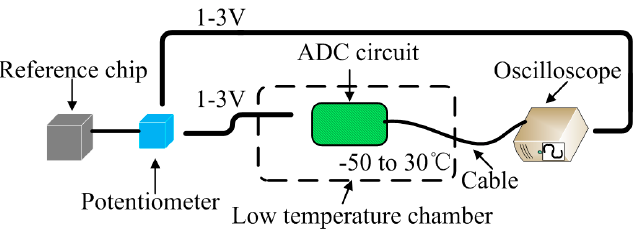
Figure 6. The schematic diagram of the experimental setup of analog-to-digital converter (ADC) circuit.